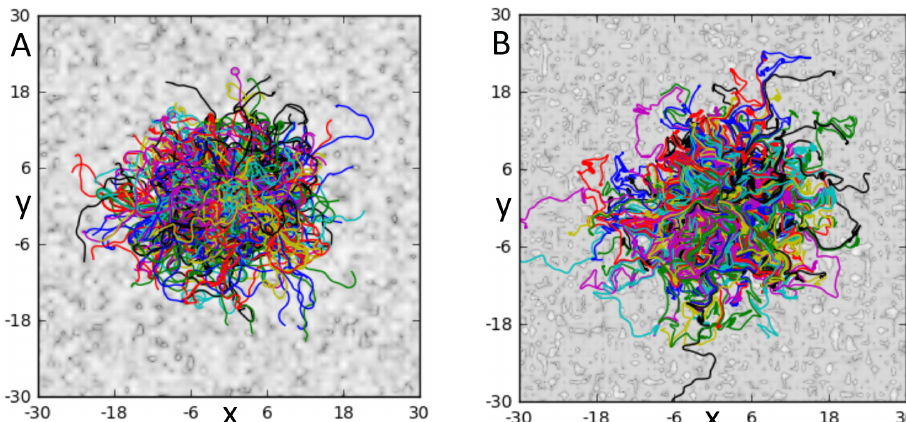
Figure 2: Generic null geodesic trajectories in the spatial plane for purely isotropic or purely nematic QGD. As discussed in the text, we consider quenched random space- times with a special temporal flatness condition, which means that 2 + 1-D Dirac car- riers are modulated by perturbations that artificially mimic gravity, but in samples defined in physically flat spacetime. It means that physical distances in a solid-state realization correspond to the Euclidean measure in the plane, rather than to the geodesic one. A: Null geodesics for a purely isotropic QGD realization. Trajecto- ries with different initial conditions (initial position and launch angle) appear with different colors. Note the qualitative resemblance to uncorrelated 2D random walks (diffusion). B: Null geodesics for a purely nematic QGD realization. Nearby geodesics are highly correlated in their direction, and tend to exhibit near-retracing orbits that bounce back and forth along nematic curvature singularity contours. Note that only in case B do singularities arise along 1D curves (domain